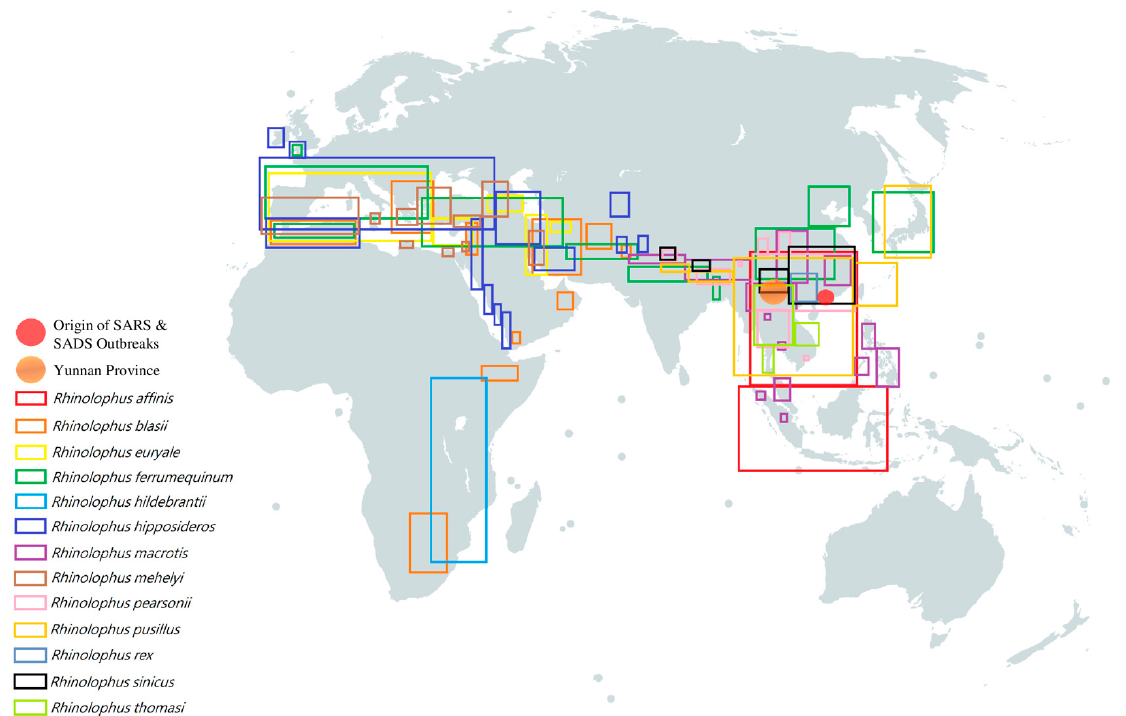
Figure 4. Geographical distribution of different horseshoe bats which were discovered to carry SARS-like BatCoV [114–125]. Each colored rectangular box represents the geographical distribution of a specific horseshoe bat species respectively: red box, Rhinolophus affinis ; orange box, Rhinolophus blasii ; yellow box, Rhinolophus euryale ; green box, Rhinolophus ferrumequinum ; turquoise box, Rhinolophus hildebrantii ; indigo box, Rhinolophus hipposideros ; purple box, Rhinolophus macrotis ; brown box, Rhinolophus mehelyi ; pink box, Rhinolophus pearsonii ; gold box, Rhinolophus pusillus ; blue-gray box, Rhinolophus rex ; black box, Rhinolophus sinicus ; lime box, Rhinolophus thomasi . Orange circle represents Yunnan Province; Red circle represents the origin of SARS & SADS outbreaks.